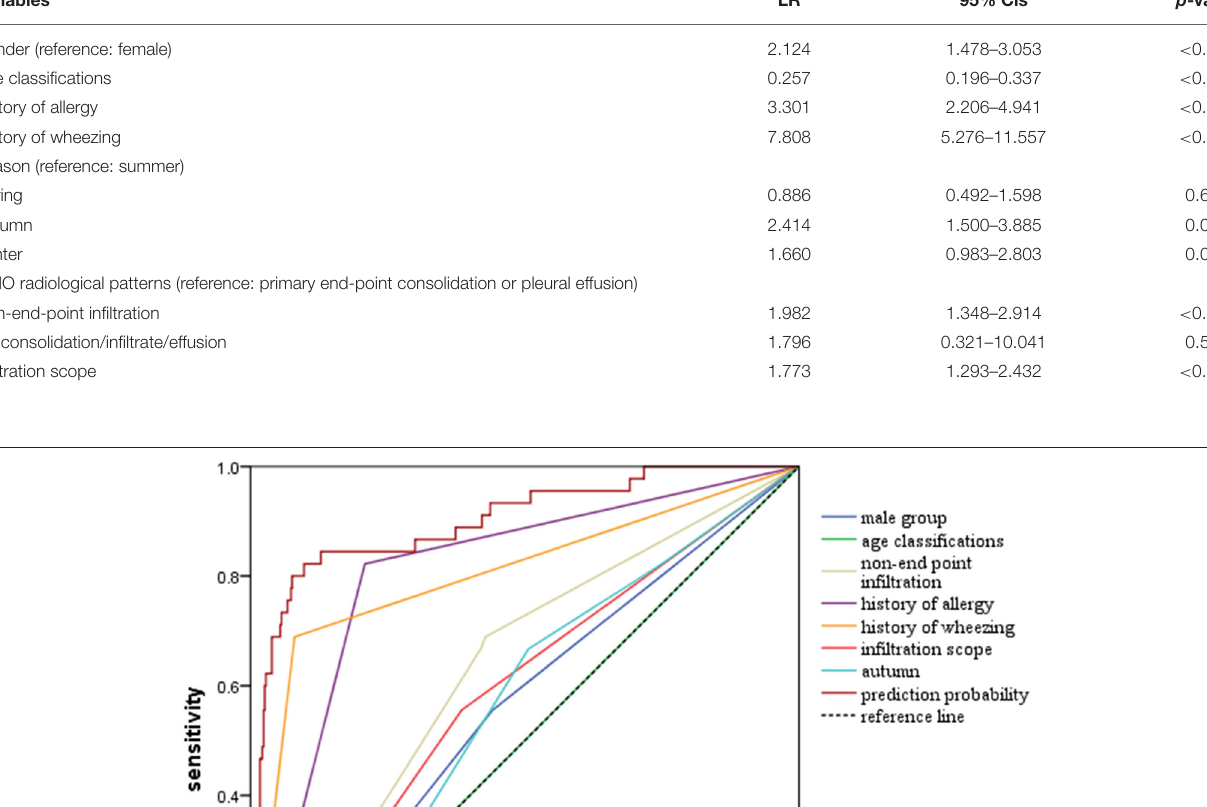
TABLE 5 | Independent odds ratios and confidence intervals for the effects of each variable on the risk of wheezing among MP-infected patients. Variables LR 95% Cis p -value